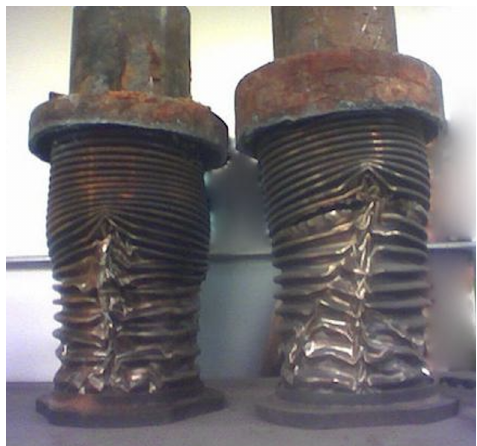
Figure 1. Effects of water hammer dynamics. (Cited from: https://en.wikipedia.org/wiki/Water_